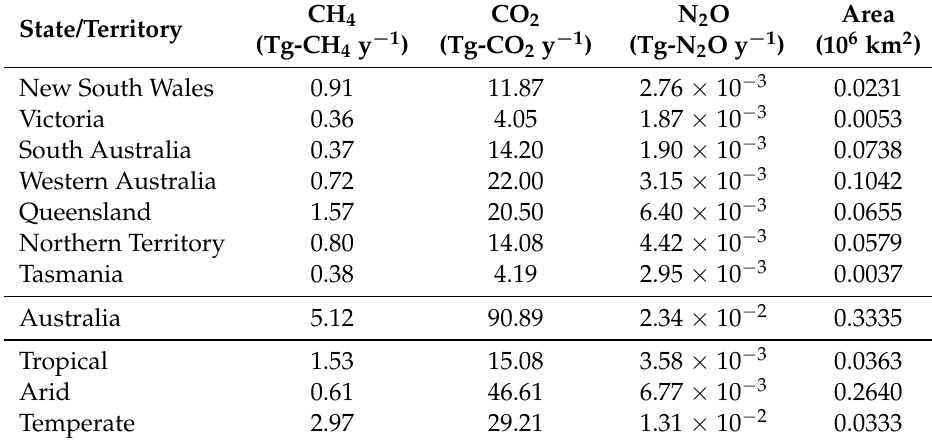
Figure 4. Annual long–term average emissions per unit of average wetland area between 2008 and 2017 of ( a ) CH 4 , ( b ) CO 2 , and ( c ) N 2 O. Table 2. Annual long-term average CH 4 , CO 2 , and N 2 O emissions and average maximum wetland area reported for each State/Territory, entire Australia, and per climatic